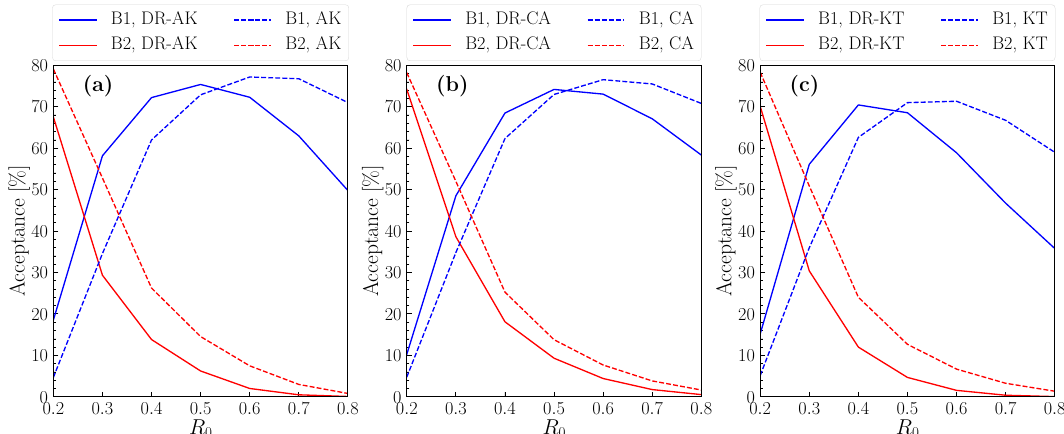
Figure 9 . The variation of A [eq. (3.1)] as a function of the starting radius R 0 for pp → V j SM process. The blue and red lines represent the values of A for categories B1 and B2 events, respectively. The dashed lines are for (a) AK, (b) CA, and (c) KT algorithms. The solid lines are for their dynamic radius